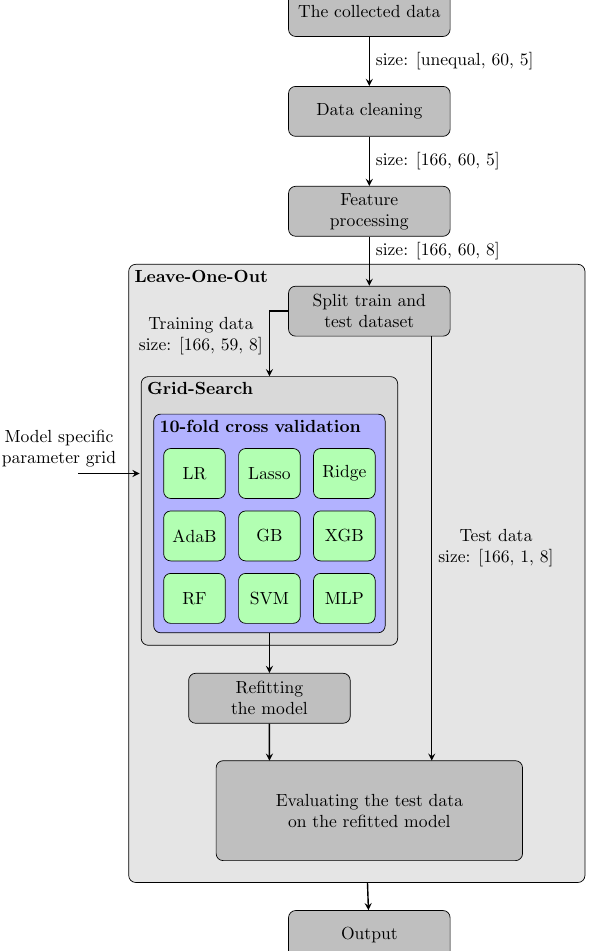
Figure 6. Evaluation pipeline employed in the present